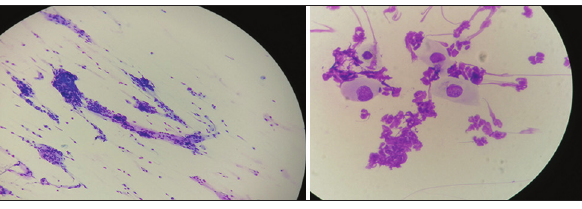
Figure-5: Cotton swab cytology sample-to the left 20× magnification, to the right 100×